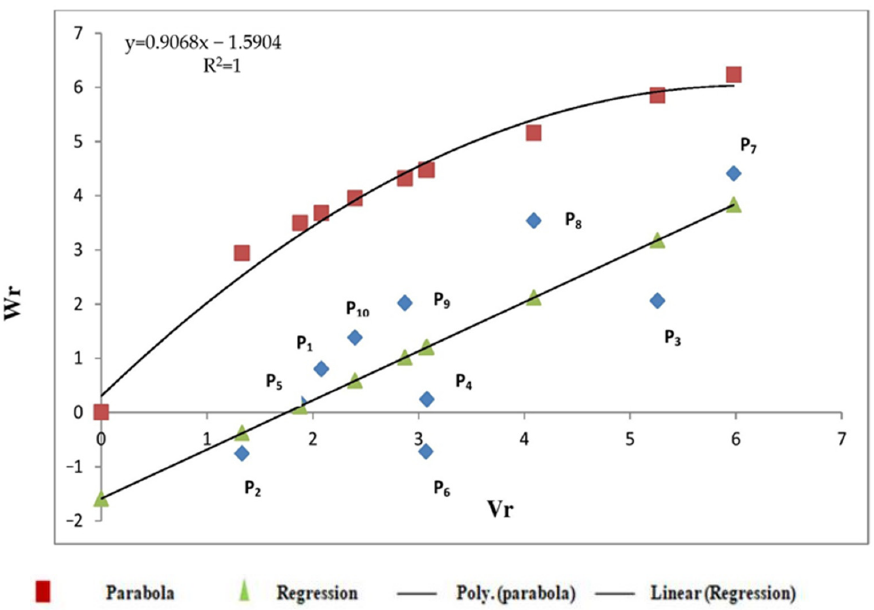
Figure 3. Wr–Vr graph for sedimentation value in E 1 . P1 = GW 451; P2 = GW 496; P3 = LOK 1; P4 =